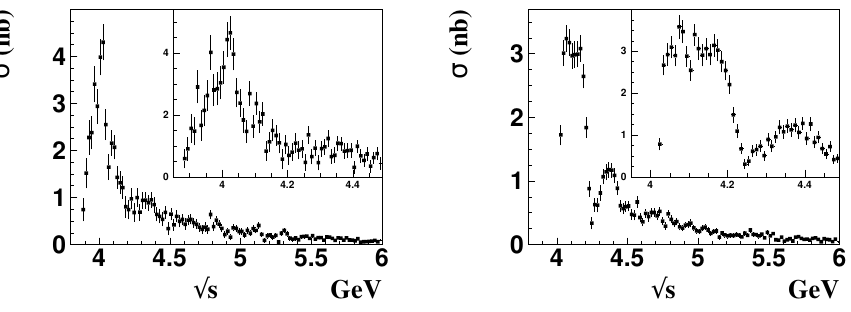
Figure 2. The exclusive cross sections as functions of √ s for e + e − (right). The insets show the zoomed spectrum near the threshold with a half-size bin